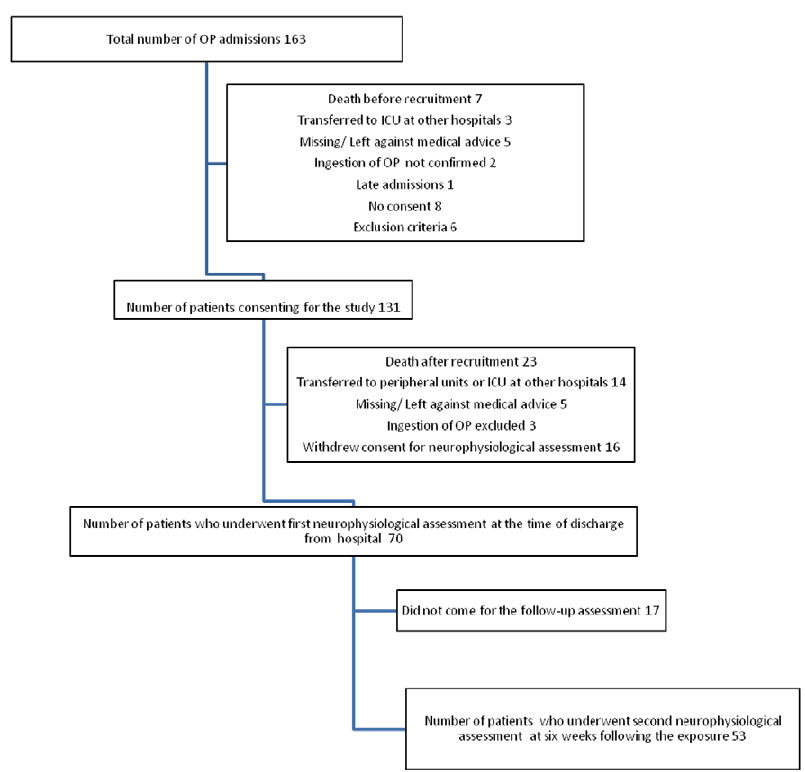
Figure 1. Flow diagram of recruitment of participants.